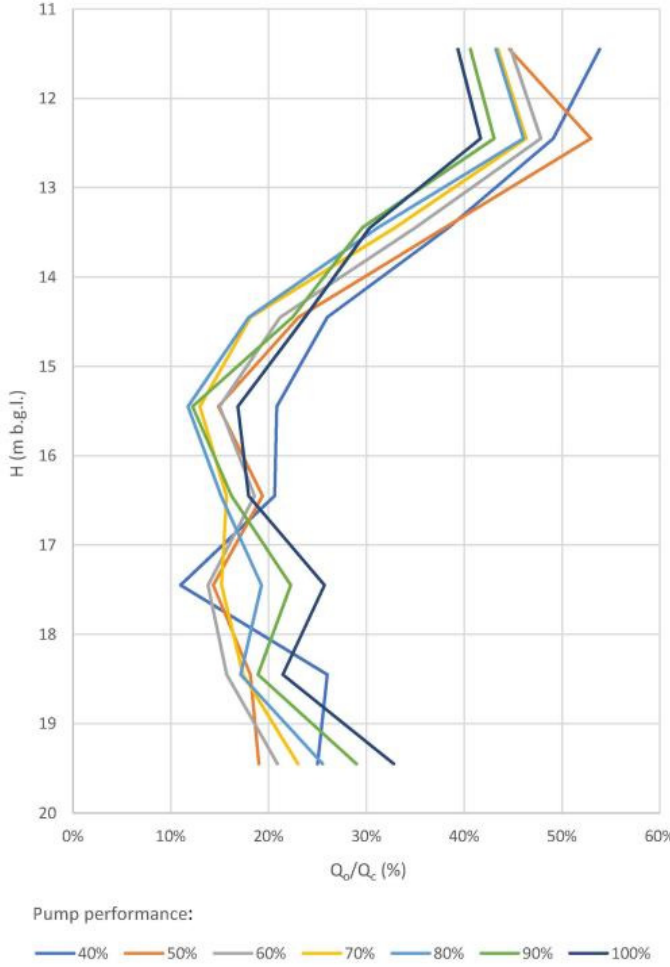
Figure 13. Pilot test on the HJ-3 extraction well on 28 July 2020-the overall profile of the HJ-3 extraction well.